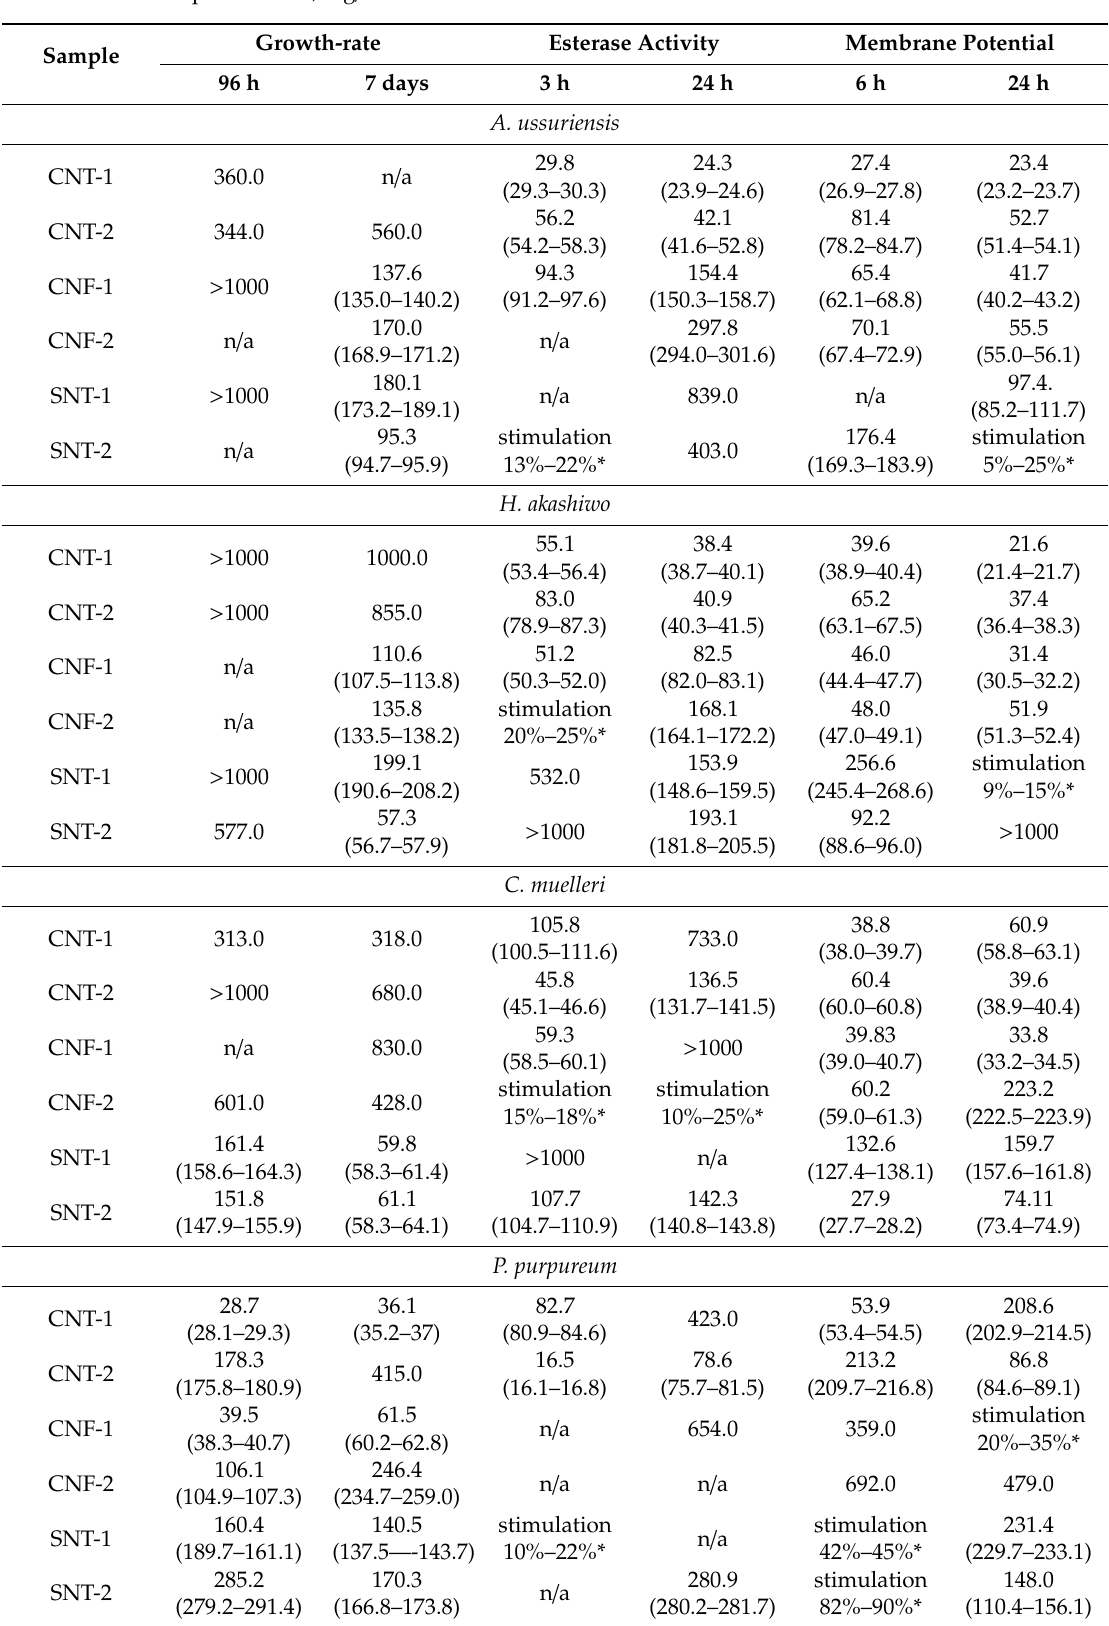
Table 3. The calculated EC 50 concentration of growth-rate inhibition, esterase activity inhibition, and membrane depolarization, mg /